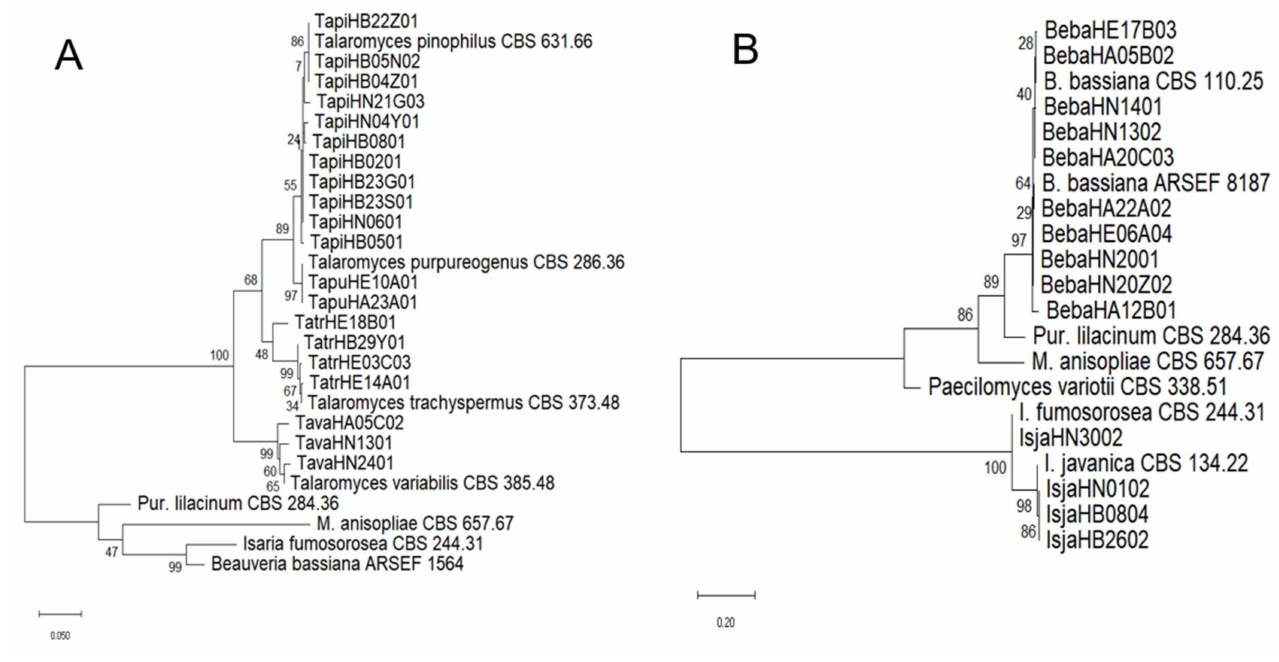
Figure 3. Phylogenetic tree of Talaromyces spp. ( A ) and Beauveria/Isaria ( B )